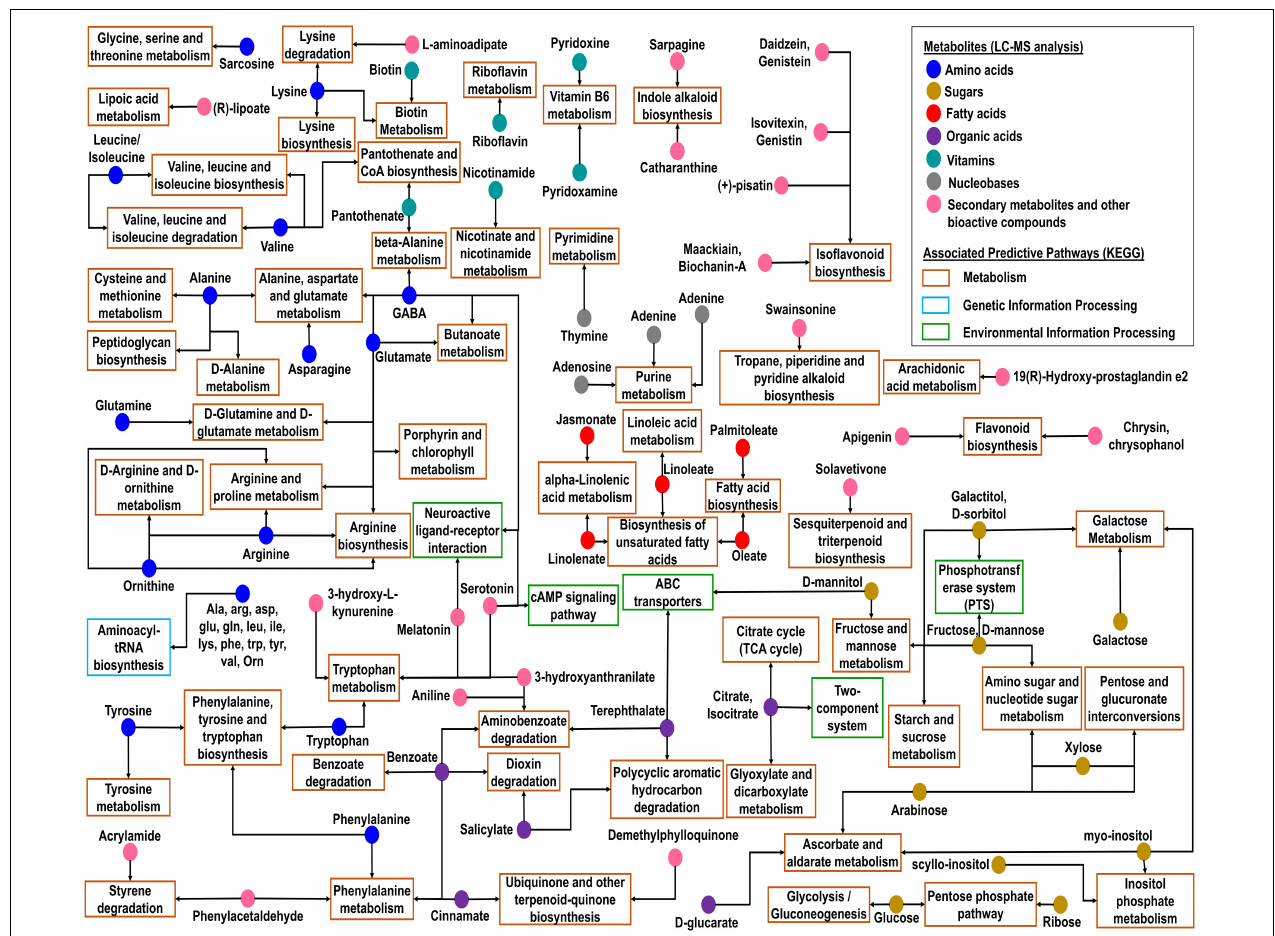
FIGURE 8 | Network and functional analysis modules of metabolites associated with predictive KEGG pathways represented via KEGG global metabolic network using MetaboAnalyst.